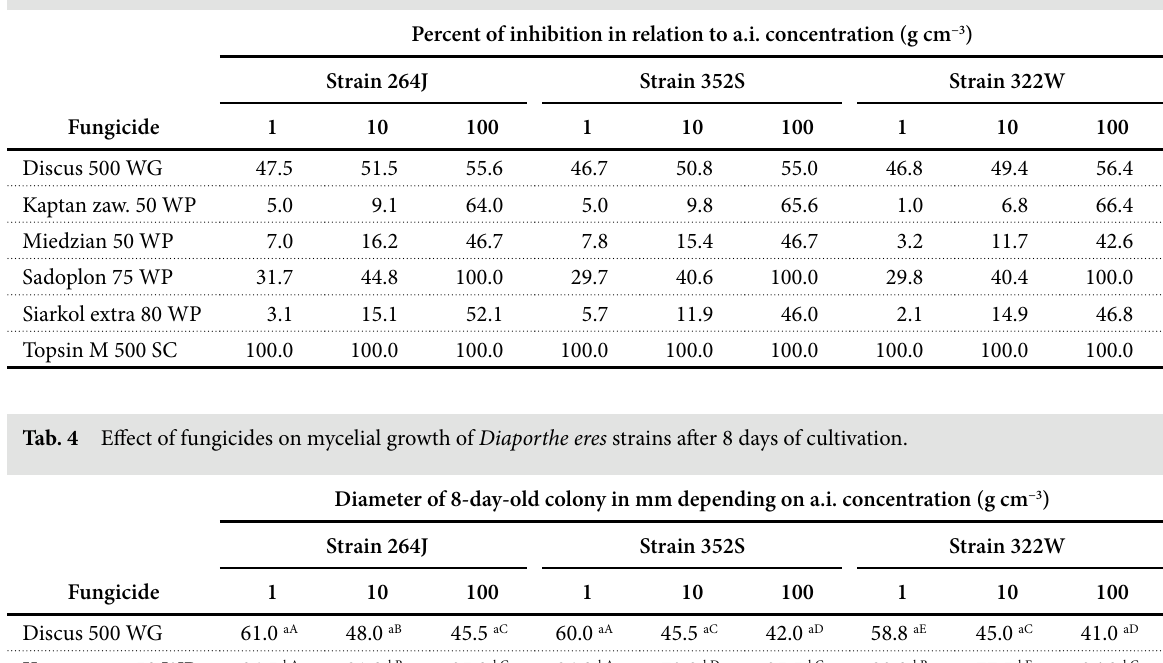
Tab. 3 Inhibition the colony growth of Diaporthe eres strains after 4 days of cultivation.